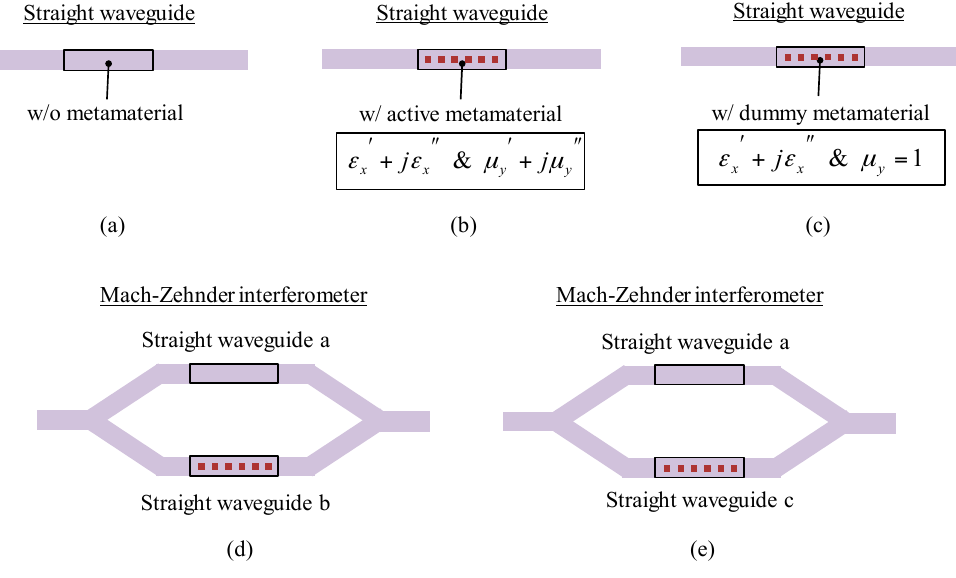
Figure 3. Waveguide elements needed for ε - μ extraction. ( a ) Straight waveguide without TGM; ( b ) straight waveguide with active TGM; ( c ) straight waveguide with dummy TGM, ( d ) MZI consisting of waveguides a and b connected with Y branches; and ( e ) MZI consisting of waveguides a and c.